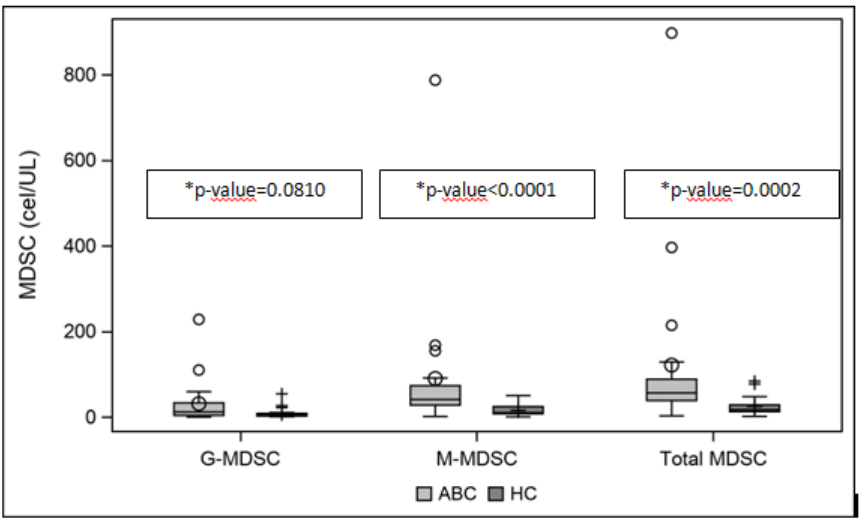
Figure 2. Baseline median values of MDSCs (G-, M-, total; cells/µL) comparison between ABC TN patients and healthy cohort. * Wilcoxon–Mann–Whitney test. Abbreviations: MDSCs = myeloid derived suppressor cells; M-MDSCs = monocytic MDSCs; G-MDSCs = granulocytic MDSCs; ABC = advance breast cancer; TN= triple-negative; HC = healthy cohort. Table 4. MDSCs levels (cells/µL) according to tumor response. with clinical benefit (CB) (Table 4). In the same way, no significant differences in MDSCs levels between patients showing CB and patients showing PD could be observed at any study time point (Table